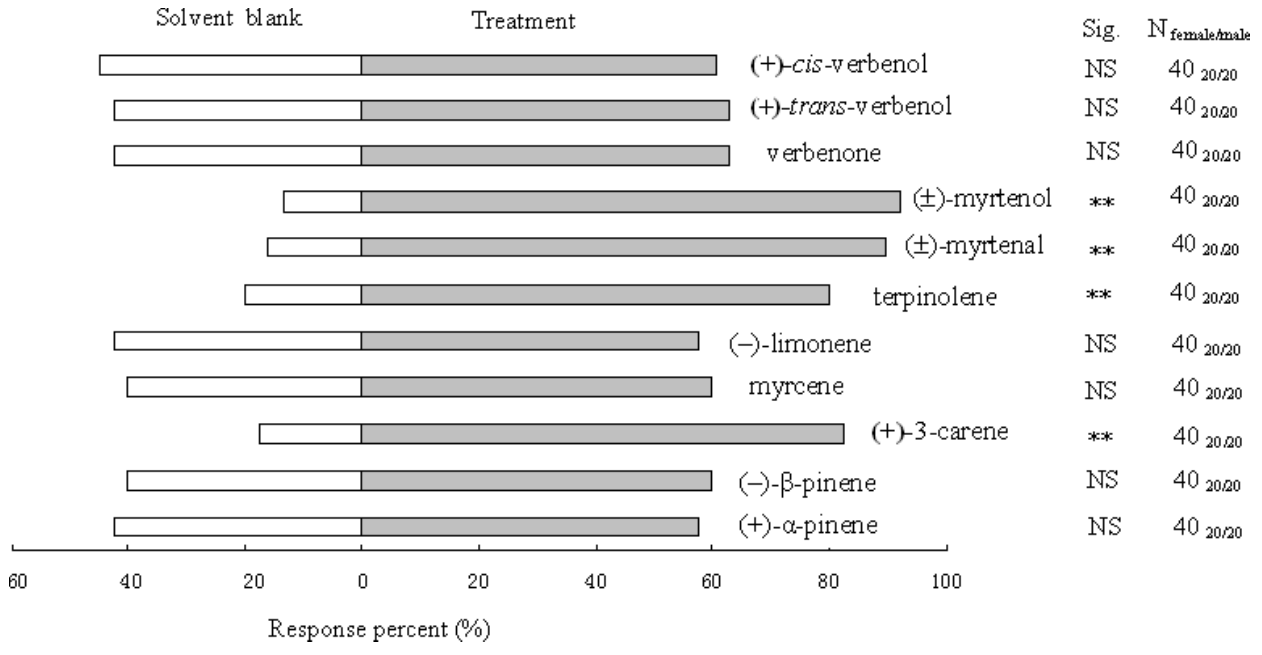
Figure 4. Walking responses of H.paralleluscompounds in Y-tube olfactometer trials. **, significant differences at P , 0.01. n =40 (20 male: 20 female) responding beetles for each treatment.